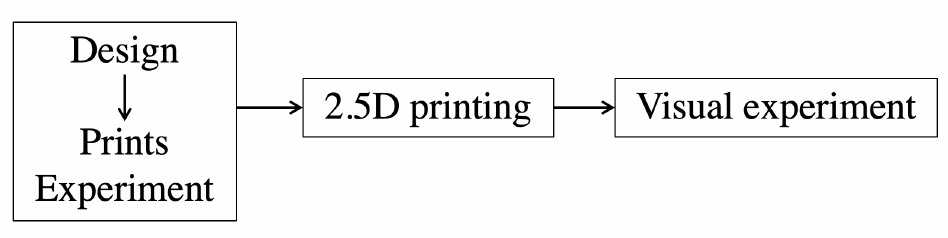
Figure 1. Our workflow. We started with designing the experiment and prints followed by 2.5D printing stage. Afterwards, we conducted the visual